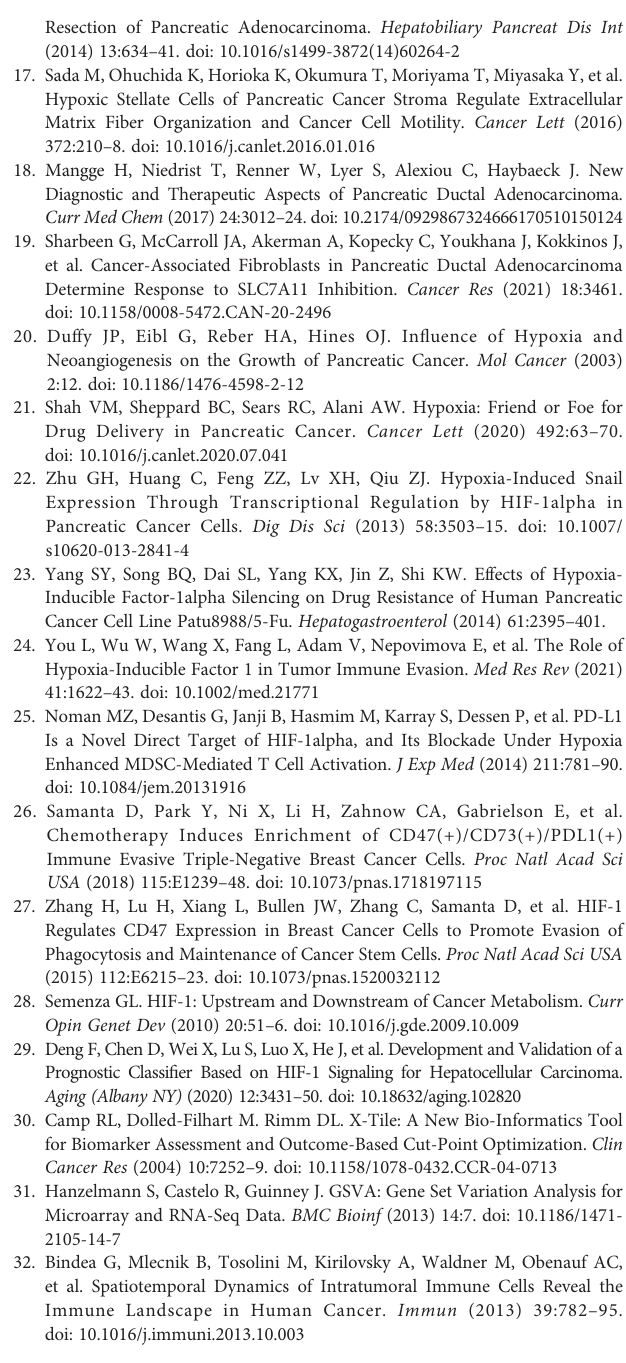
Supplementary Figure 3 | Heatmaps to show the top 20 differential oncologic biological pathwaysandmetabolicprocessesbetween differentHIF-1scoregroups were respectively presented using heatmaps. Supplementary Figure 4 | (A) Association between HIF-1 score and PD-L1 expressioninPDAC. (B) AssociationbetweenHIF-1scoreandB7-H3expression in PDAC. (C) Patients in patients in squamous subtype had signi fi cant higher HIF-1 score than those in immunogenic subtype. PDAC, pancreatic ductal adenocarcinoma. ****P value <